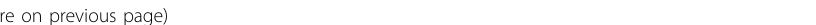
Fig. 4 Catalase expression is epigenetically regulated in CLL cells. A Human catalase promoter possesses two distinct CpG-islands. Genomic DNA from normal B-cells (N14, N15) and CLL cells (P29 – P31) were bisul fi te converted and the predicted CpG-Islands in the catalase promoter were PCR ampli fi ed using methylation/unmethylation-speci fi c (M/U) primer sets. PCR products were analyzed on agarose gels and photographed. B , C Methylation status in CpG-Island-I determines catalase expression in CLL cells. Genomic DNA from normal B-cells ( n = 5; N14 – N18) and CLL cells ( n = 32; P29 – P48, P51 – P62) were bisul fi te converted and the CpG-Island-I and -II in the catalase promoter were PCR ampli fi ed as described above and sequenced. Representative DNA sequence analyses from normal B-cells and CLL cells are shown and compared ( B ). A diagrammatic presentation of the methylation status in CpG-Island-I and – II of the catalase promoter in normal B-cells ( n = 5; N14 – N18) vs. CLL cells ( n = 13; P29 – P41) (obtained from the sequence analysis data) is shown in panel C . Each spliced rectangle (representing both alleles of the gene) indicates a putative CG- methylation site; half- fi lled rectangle represents methylation at one allele; fi lled rectangle represents methylation at both the alleles; empty rectangle indicates no methylation at either alleles. D CpG-Island-I in CLL cells is methylated differentially. Methylation status of the fi fteen putative CpG sites in Island-I of the catalase promoter in CLL cells ( n = 19; P42 – P48, P51 – P62) was determined by analyzing the sequence data described above and presented as “ Degree of Methylation ” . E Degree of Methylation in CpG-Island-I inversely correlates with catalase protein levels. CLL cell lysates as available from few CLL patients analyzed in panel D (P42 – P45, P47, P48, P53) were examined for catalase expression in western blots. Normalized catalase protein levels (with respect to GAPDH) in CLL cells were further analyzed to fi nd any correlation with the degree of methylation in CpG- Island-I of the catalase promoter. F Methylation status of CpG-Island-I in B-cell lymphoma cells. Similarly, degree of methylation in CpG-Island-I of the catalase promoter in other B-cell malignancies including diffuse large B-cell lymphoma (DHL2, LY3) and mantle cell lymphoma (Mino) was also determined. G , H Treatment of malignant B-cells with 5 ’ -azacytidine increases catalase expression. DHL6/MEC1 cells ( G ) or primary CLL cells ( H ; n = 4; P57, P65 – P67) were treated with a demethylating agent 5 ’ -azacytidine (AZA; 1 µM) or left untreated. Catalase mRNA levels were determined by